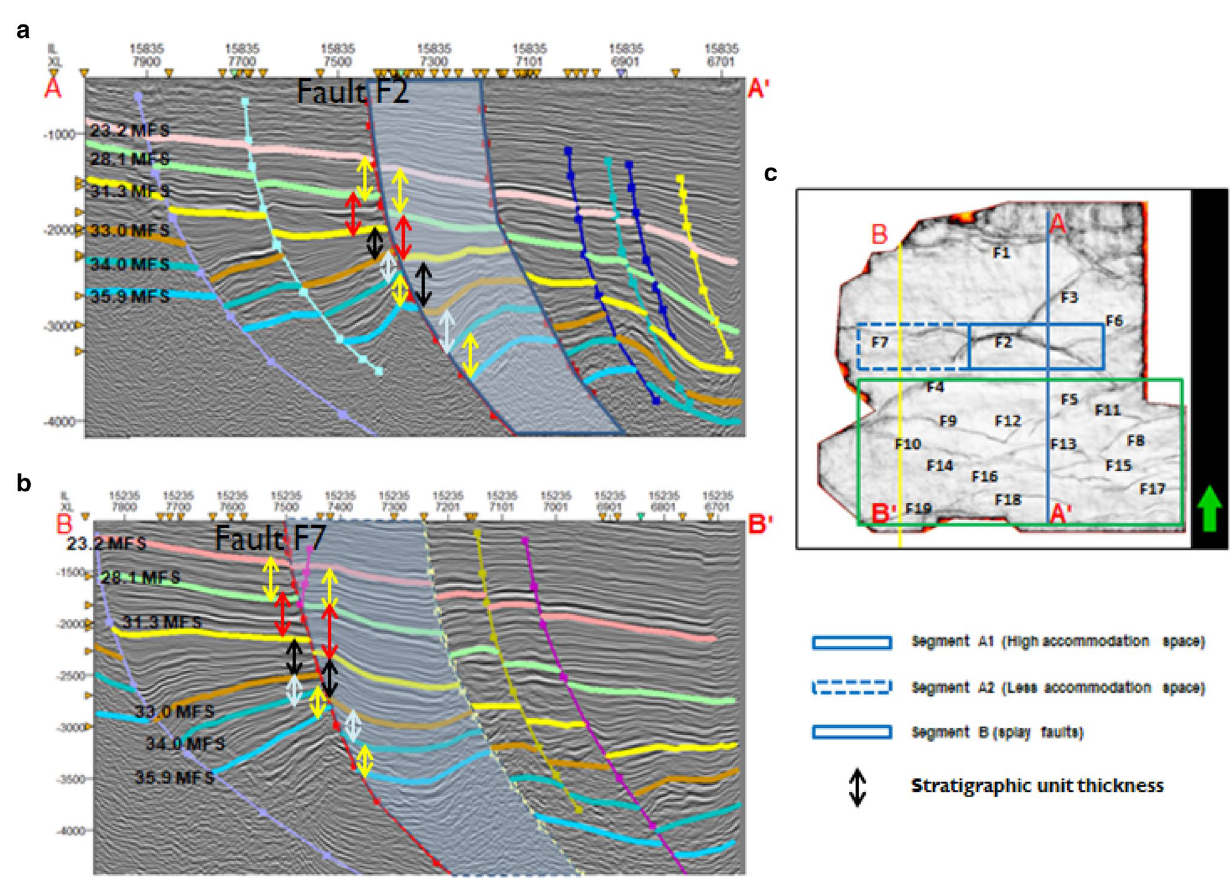
Fig. 16 Seismic traverses showing different growth faults and respec- tive stratigraphic geometries a line A–A ′ showing fault 2 adjacent stratigraphic relationship in segment A, b line B–B ′ showing fault 7